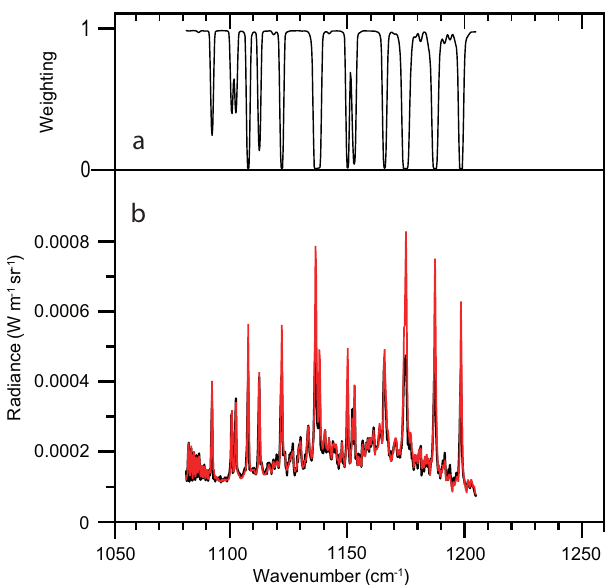
Fig. 4. Thermal emission spectrum (below) around the SO 2 ν 1 -band on 17 November 2008 at 17:45LT. The black trace is the measured spectrum in the direction of (B) depicted in Fig. 1, and the red trace corresponds to the fitted simulation. The H 2 O cross-section (above) is used for systematically deweighting the water lines in the analysis.